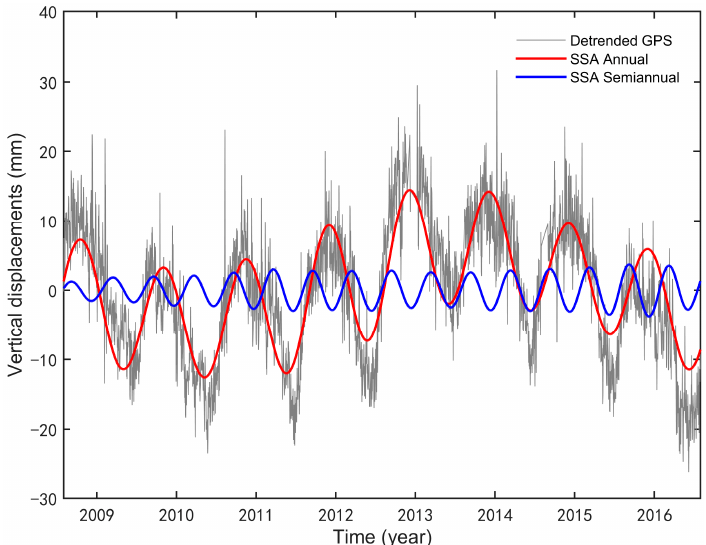
Figure 8. Vertical coordinate time series (detrended) of the KAGA station, annual and semiannual signals extracted by the SSA method.